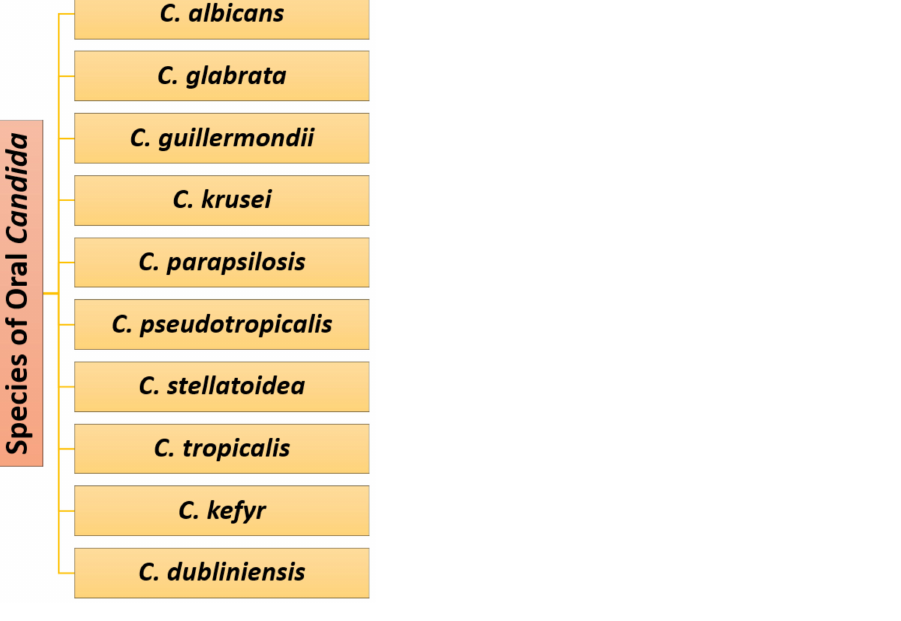
Figure 2. Candida spp. causing oral candidiasis. Created based on information from literature references